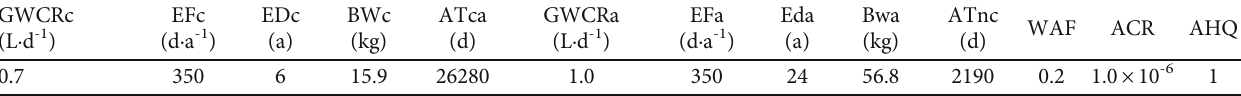
Table 2: Recommended value of risk assessment model parameters via drinking water in sensitive land use.